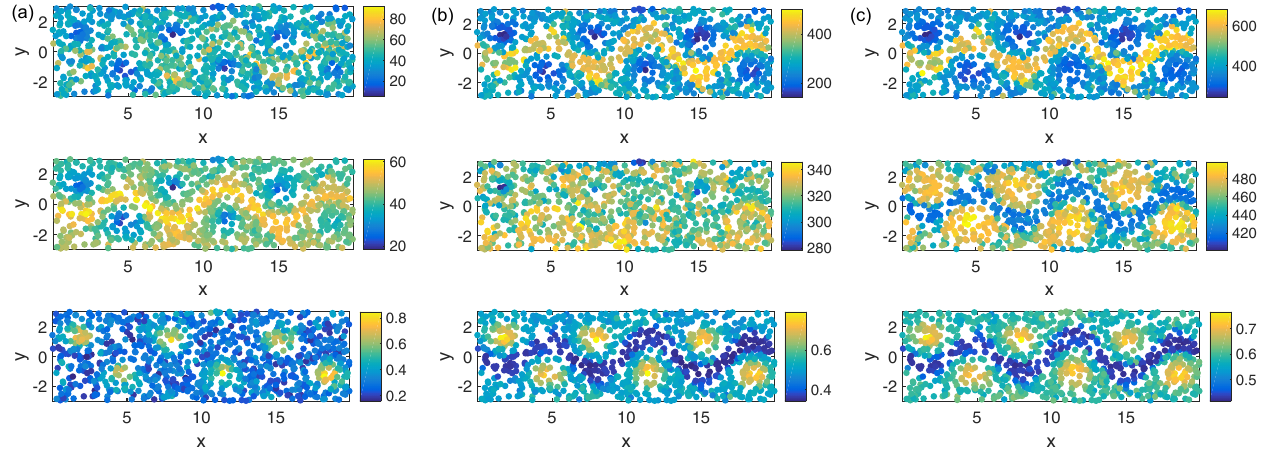
Figure 2. Network measures for 1000 random initial conditions (case ii) in the Bickley jet for (cid:15) = 0 . 5 (a) , (cid:15) = 1 . 5 (b) , and (cid:15) = 1 . 9 (c) . From top to bottom: node degrees d and (cid:104) d (cid:105) nn and clustering coefficient C .